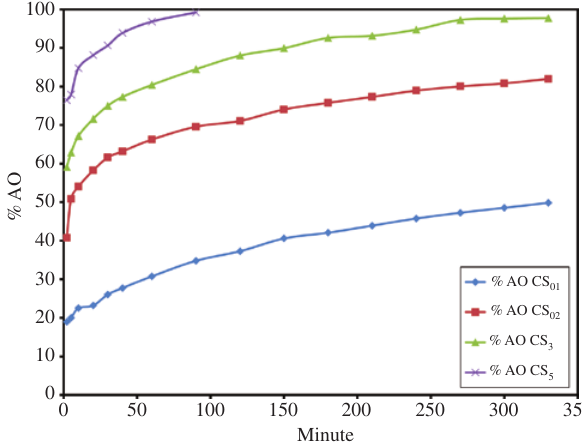
, CS , CS , and CS 3 4 5